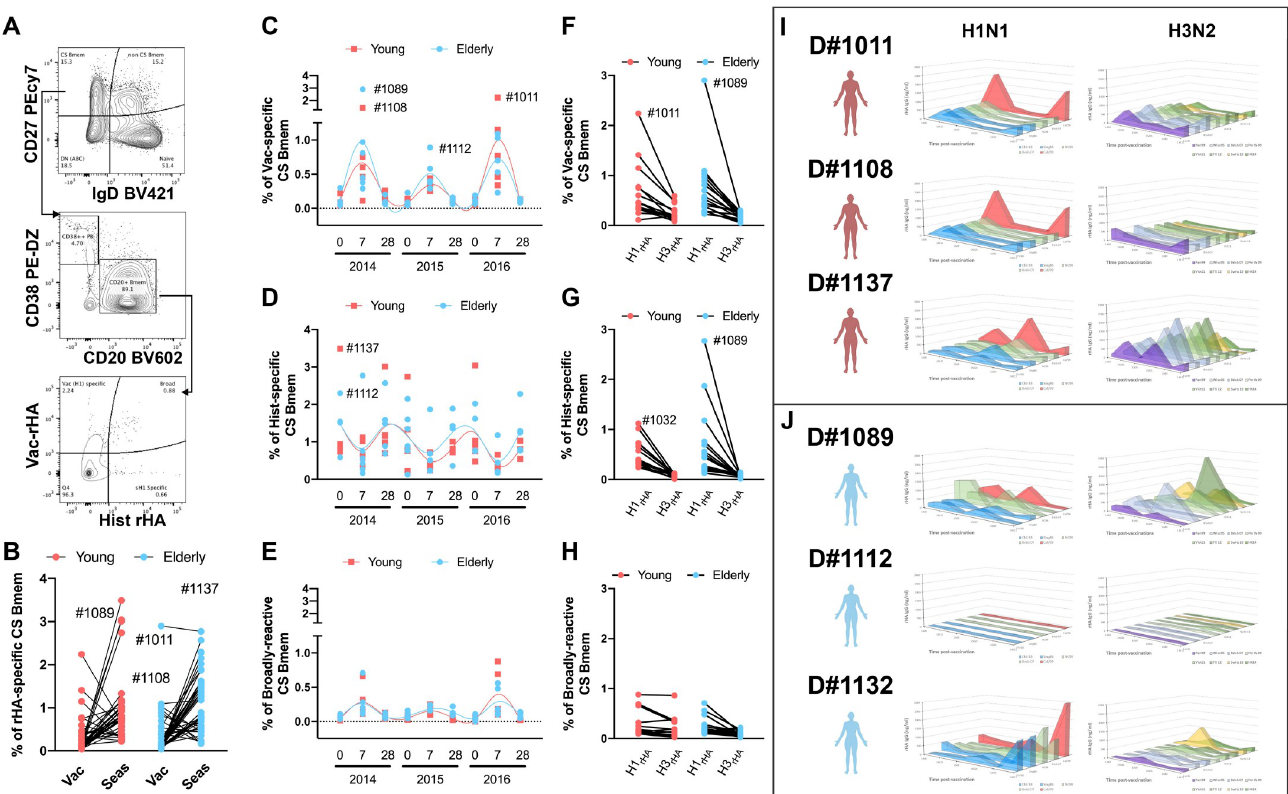
Fig 6. Class-switched memory B-cell (CS-Bmem) responses in young and elderly participants vaccinated for three consecutive years. A) Representative gating strategy to quantify rHA-specific CS-Bmem in the peripheral blood of vaccinated participants. B) Percentage of vaccine-specific and historical-specific CS-Bmem in the peripheral blood of young (red) and elderly (blue) vaccinated participants. C-E) Percentage of vaccine-specific (C), historical-specific (D) and broadly- reactive (E) CS-Bmem in young (red) and elderly (blue) participants vaccinated for three consecutive years. Lines show cubic spline interpolation model for young adult (red) and elderly (blue) participants. F-H) Percentage of H1N1 and H3N2 vaccine-specific (F), historical-specific (G), and broadly reactive (H) CS-Bmem in young adult(red) and elderly participants vaccinated for three consecutive years I) Bmem-derived IgG antibodies against rHA from current vaccine strain and historical seasonal virus strains, as in Figs 4 and 5, in three young adult (red) and three elderly (blue) participants vaccinated for three consecutive years.